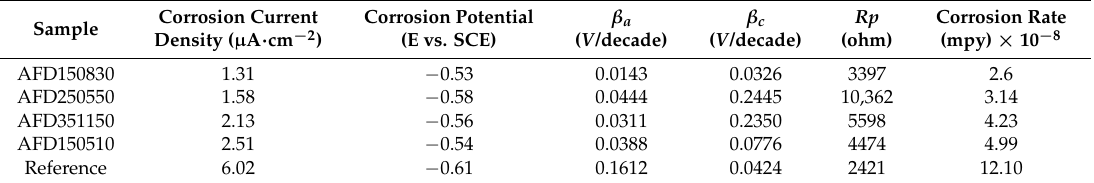
Table 4. Results of dynamic polarization test in 3.5 wt % NaCl solution at scanning rate of 0.0002 V/s consist of corrosion current, corrosion potential, polarization resistance and corrosion